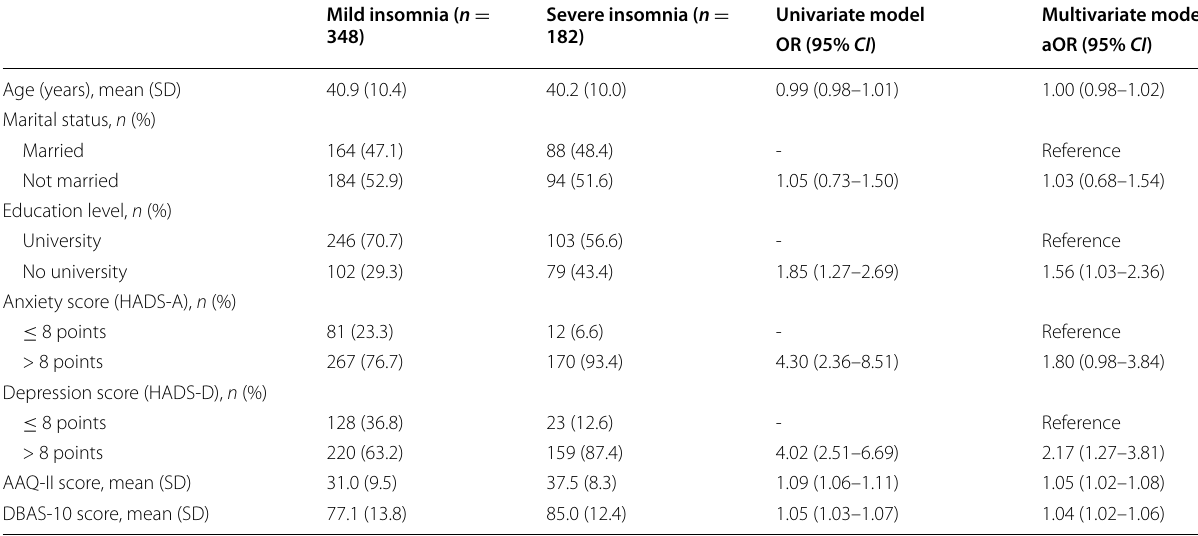
Table 2 Associated sociodemographic factors of severe insomnia and associated cognitive and psychological factors of severe insomnia